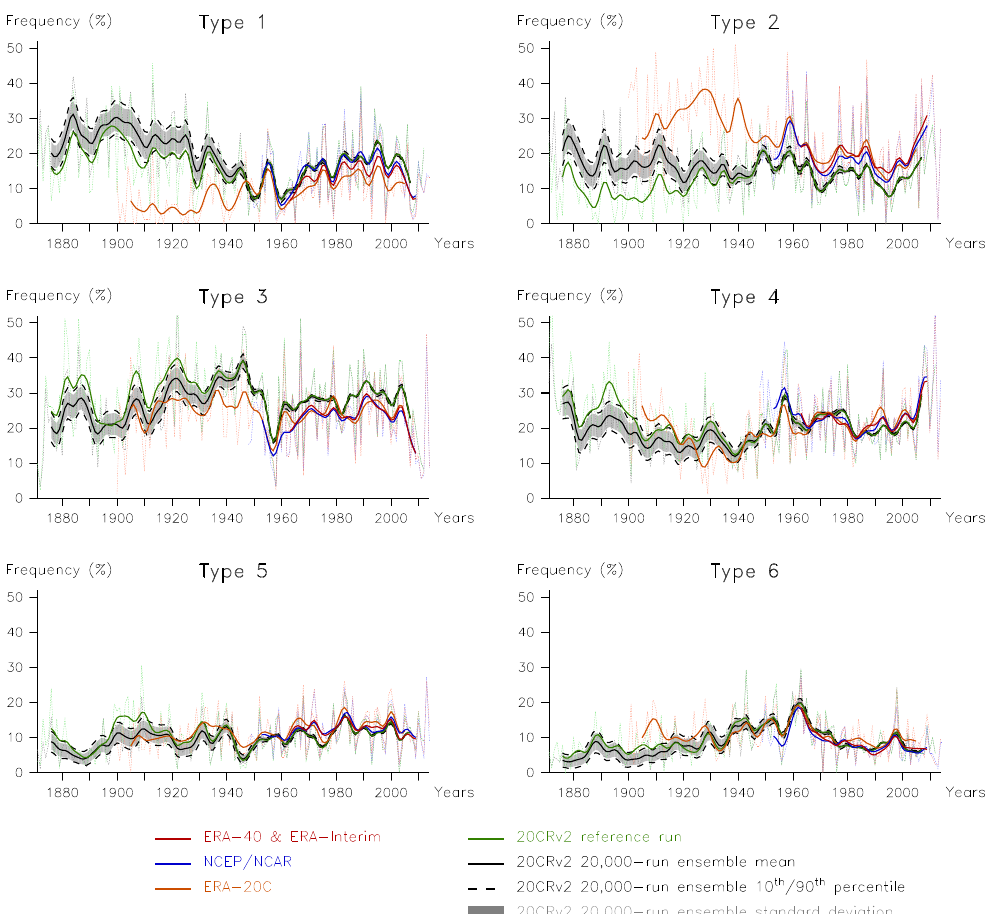
Figure 2. The dotted light lines represent the annual (JJA) SLP-based circulation type frequencies for ERA-Interim (1979–2014) and ERA- 40 (1958–1978), NCEP/NCAR (1948–2014), ERA-20C (1900–2010), and the 20CRv2 reference run and the 20CRv2 20000-run ensemble mean (1871–2012). The corresponding solid lines represent the 10-year binomial running mean frequencies. For the 20CRv2 20000-run ensemble, the 10th and the 90th percentiles as well as the 1 standard deviation interval around the mean are also